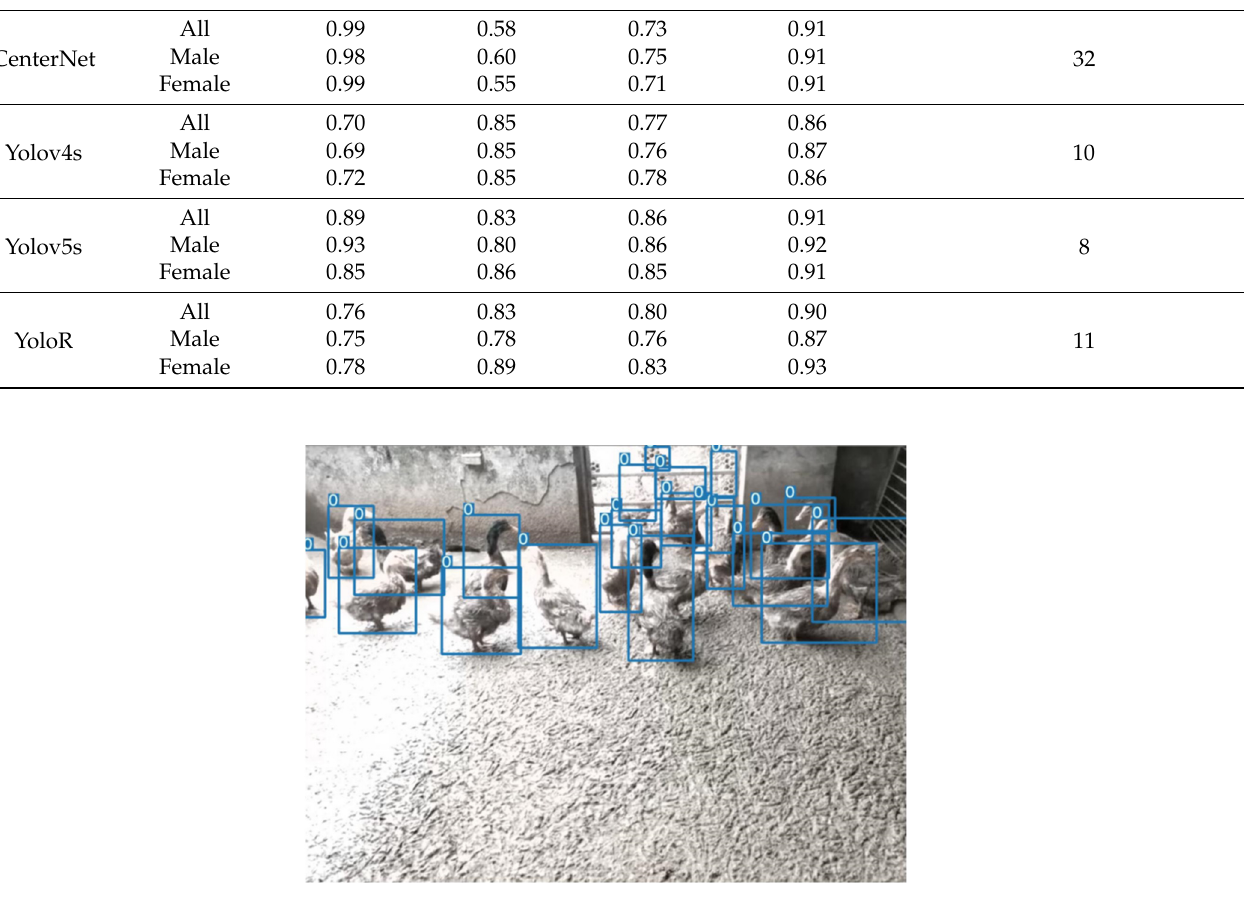
Figure 11. The effect of the Yolov5 detector (without tricks). The 0 in the image represents the single category detected and the blue rectangular in the image represents the target detection frame. Because this is a detector comparison experiment, the category information for the detected objects in the image is not labelled.